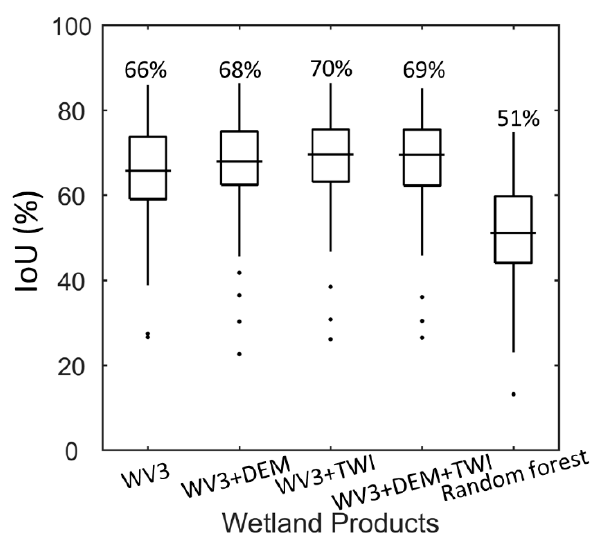
Figure 9. The intersection of union (IoU) calculated between different wetland inundation results and the lidar intensity-derived inundation labels. The percentages above each boxplot bar are the median IoU values. WV3: WorldView-3, DEM: Digital Elevation Model, TWI: Topographic Wetness Index.